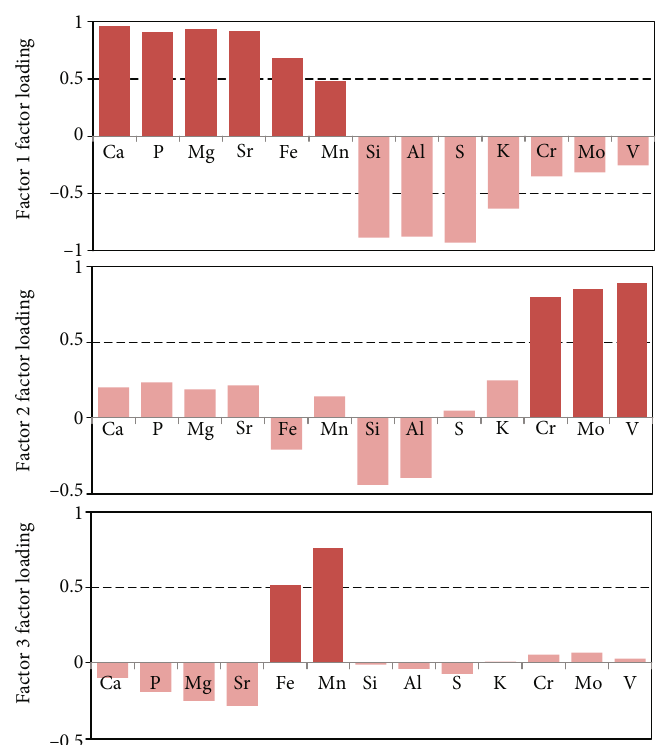
Figure 14: Varimax rotated factor loadings extracted by principal component analysis (PCA) on XRF data. The highest factor loadings are dark color-shaded. These three factors account for 86.8% of the total variance, and the extraction rates of all elements are > 60%.